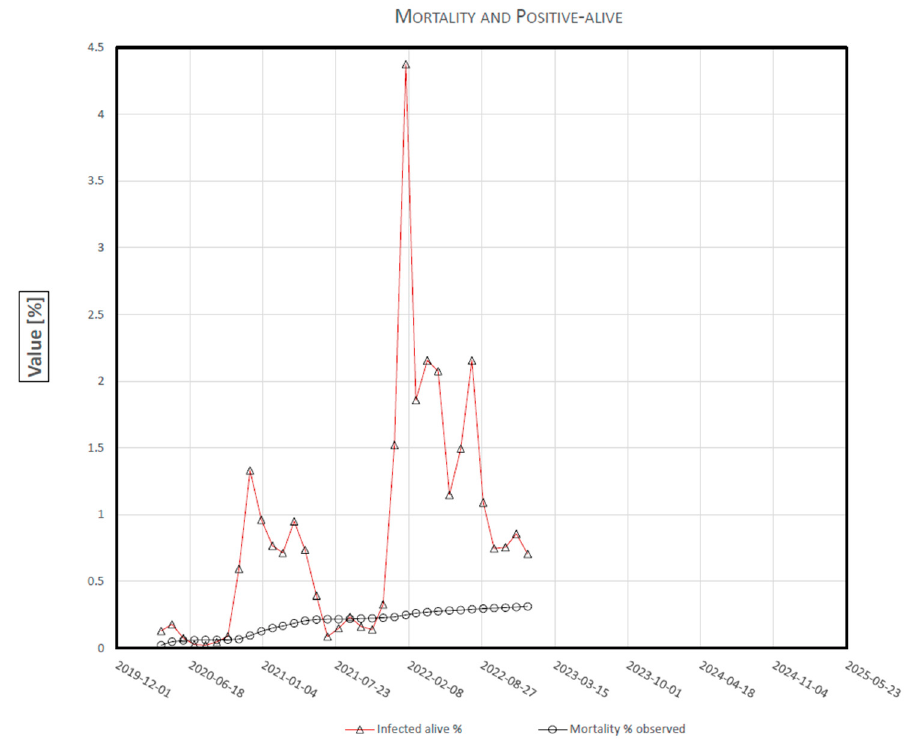
Figure 1. COVID-19 Mortality and Positive-Alive, in Italy. The values k 1 , k 2 , K, and the asymptote k 2 /K were calculated from the Mortality equation (see 2.2 Model—The formal solution) by best fitting the data using the Ordinary Least Squares method (OLS) (Table 2).